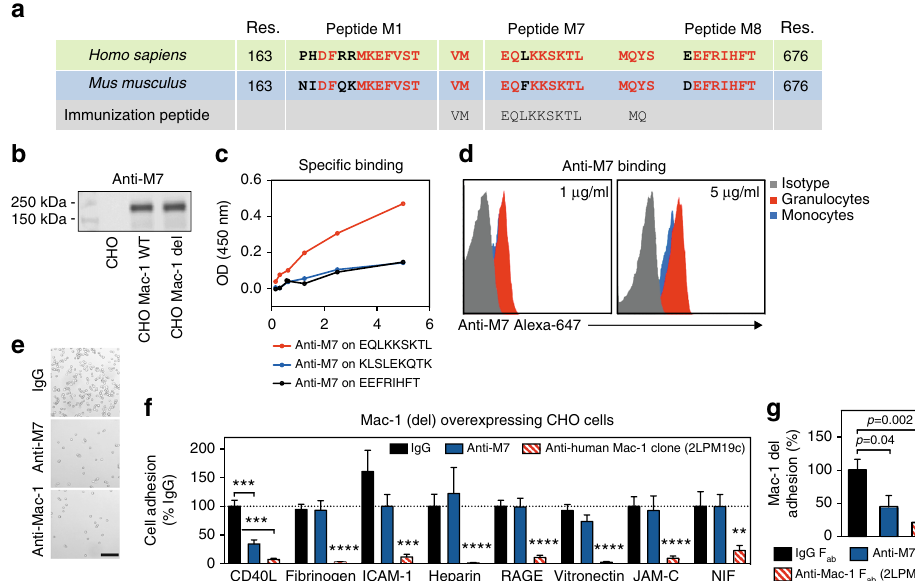
Fig. 1 The novel monoclonal antibody anti-M7 selectively blocks the CD40L-binding site within the Mac-1 (CD11b/CD18) I-domain. a The peptide sequence M7 within the Mac-1 I-domain, required for binding of CD40L, is a highly conserved binding motif between the human and mouse integrin. The antibody anti-M7 was generated by immunization of mice with the binding peptide VMEQLKKAKTLMQ coupled to diphtheria toxoid. b Anti-M7 bound to a CHO cell line over-expressing native human (Mac-1 WT) and permanently activated human Mac-1 (Mac-1 del), but not to control CHO cells that did not express Mac-1 (CHO) in western blot. c Speci fi c binding of the antibody anti-M7 to the immobilized peptides M7 (EQLKKSKTL), the scrambled control sM7 (KLSLEKQTK), and the closely located peptide M8 (EEFRIHFT) in a solid-phase binding assay with immobilized peptides. d Anti-M7 was coupled with the fl uorochrome Alexa-647 and binding to human leukocyte subsets was quanti fi ed in fl ow cytometry. An Alexa-647 labeled IgG isotype antibody served as control. e , f Adhesion of CHO cells over-expressing the permanently activated Mac-1 mutant (del) on dishes coated with immobilized human CD40L or alternative human Mac-1 ligands in a static adhesion assay. Cells were incubated with anti-M7 or the human pan I-Domain blocking anti-human reference anti-Mac-1 (clone 2LPM19c) 15 min prior to adhesion. g CHO-Mac-1 cell adhesion on immobilized CD40L was blocked with F ab fragment preparations of IgG, anti-M7 or anti-human Mac-1 (2LPM19c). Error bars indicate mean ± SEM. Statistical signi fi cance was assessed by an unpaired, two-sided Student ’ s T-test between the indicated groups, ** P < 0.01, *** P < 0.001, **** P < 0.0001 ( f , g ) or against IgG if not otherwise indicated ( f ). Data are the result of N ≥ 3 independent experiments. Representative pictures are shown in b , e . res. indicates the location/residue within the Mac-1 protein sequence. Scale bar ( e ) represents 100 μ (CD11/CD18), and RAGE to avoid unspeci fi c F c -receptor